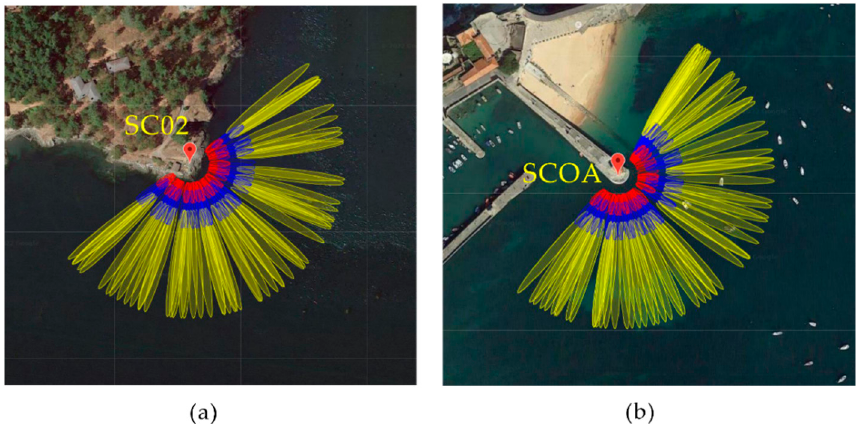
Figure 3. Screenshots of the FFZs for site SC02 ( a ) and site SCOA ( b ) at elevation angles of 5° (yellow), 10° (blue), and 15° (red), respectively. A fixed reflector height is projected onto the aerial image provided from Google Earth App [ 36 ] .